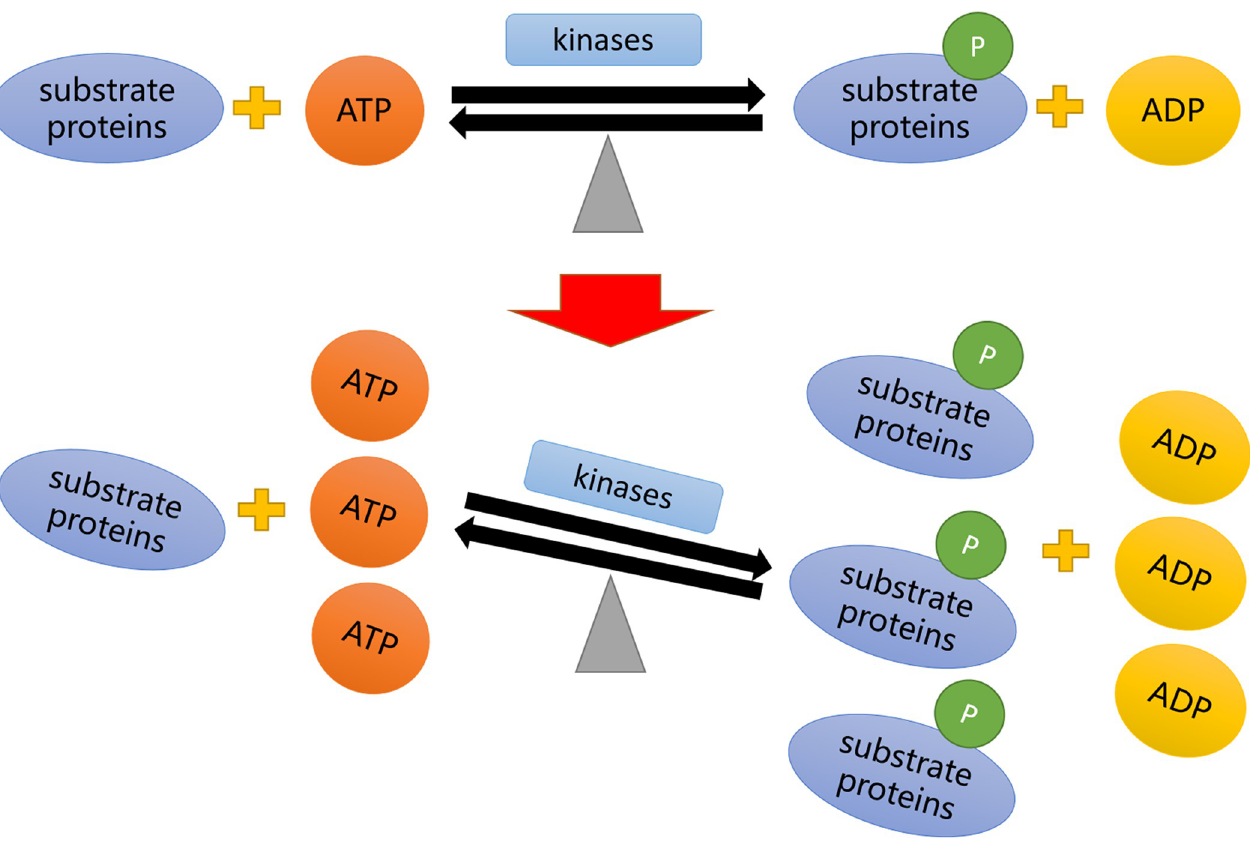
Fig 6. Schematic diagram of in vitro phosphorylation